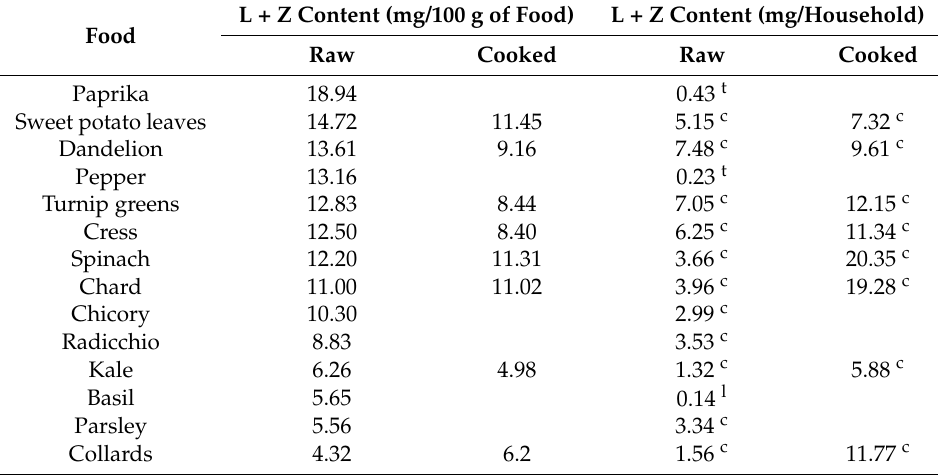
Table 1. Lutein and zeaxanthin content of some fresh foods (mean serving) a